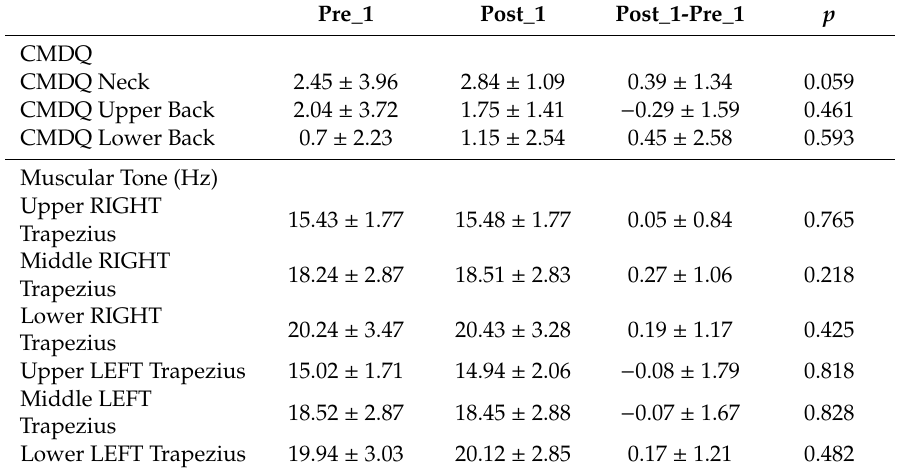
Table 2. Musculoskeletal discomfort and muscle tone in the initial assessment in pre and post workday evaluations ( n = 26). Data are expressed as mean ±